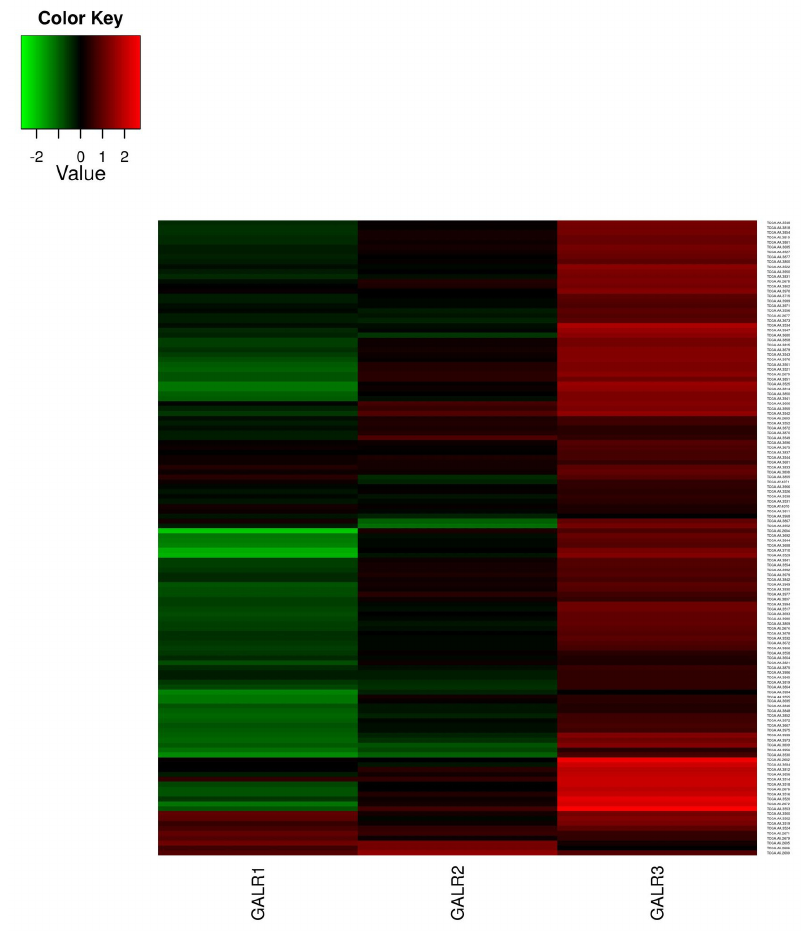
Figure 7. The normalized expression values of GalR mRNA from the TCGA COAD database. The columns describe GalR mRNA members, the rows show the ID of patients participating in colo- rectal cancer research. The bottom seven rows describe the expression of GalR mRNA in an adja- cent normal part of the colon ( n = 7). The remaining rows ( n = 129) indicate the expression of GalR mRNA within colorectal